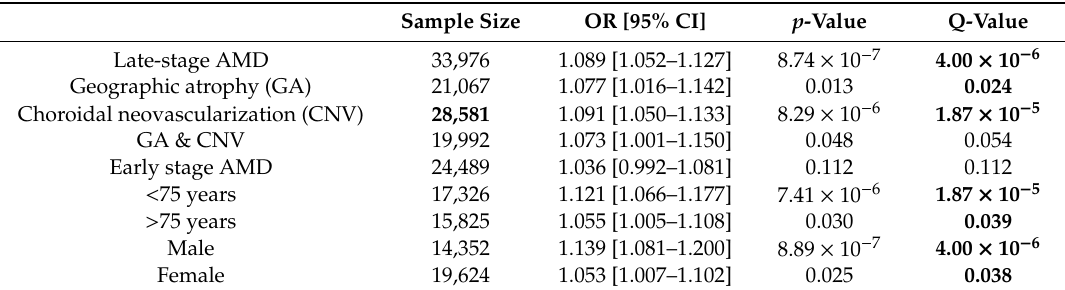
Table 1. Association of rs2168518 with AMD subtypes in the IAMDGC dataset. For all associations, the A allele indicates the e ff ect allele. Associations were calculated in comparison with the respective non-AMD individuals. Q-values < 0.05 are indicated in bold.